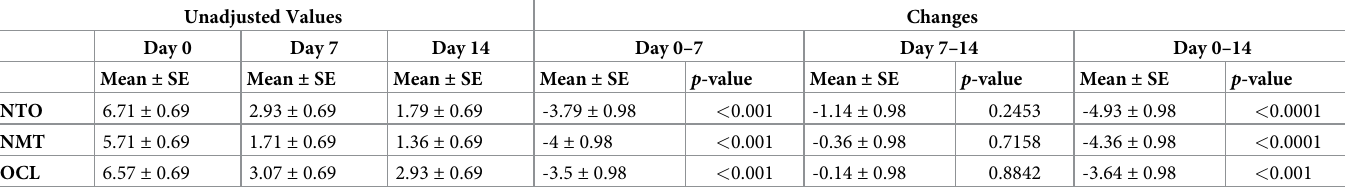
Table 2. Unadjusted mean UD scores and differences in mean UD